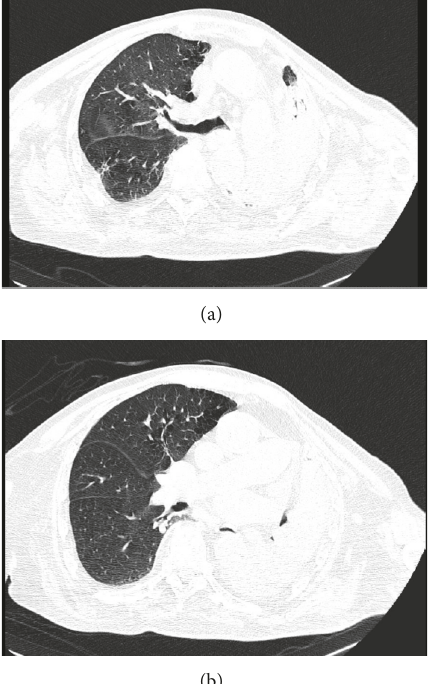
Figure 2: Chest CT scan: left bronchus mucus plug.